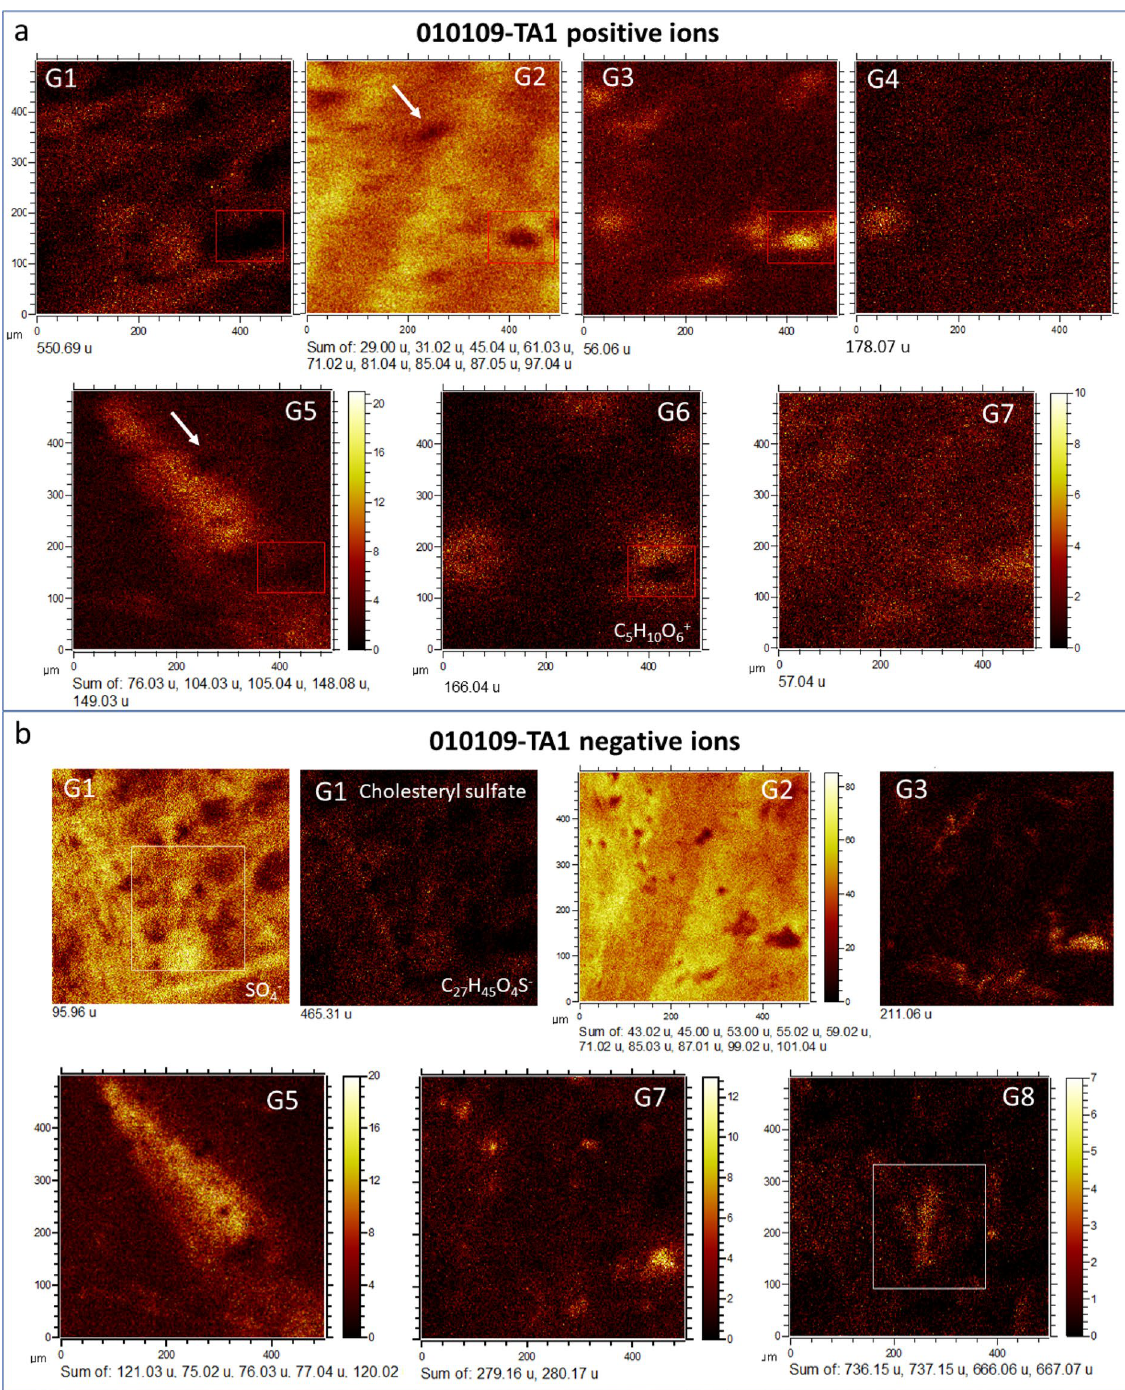
Figure 4. Occurrence of different biological microstructures in Target Area 1 (TA1) characterized by the imaging capabilities of ToF–SIMS as morphological Groups 1 to 8 through their molecular compositions. ( a ) Groups 1 to 8 outlined by the distribution of ( a ) positive and ( b ) negative fragments. The red rectangle traces a nodular microstructure in G3 occurring as an empty and complementary cast in G2, G5 and G6. The white rectangle encloses branched filamentous structures in G8 that complement part of the filamentous structures in G1 (see Fig. 5) suggesting that the fungal filamentous structure show compositional variations. The white arrow points at a void (see Supplementary Fig. 2) that is affecting some microstructures in G2 and G5. As discussed in the main text, the composition and structure of groups G1 to G8 suggest that the groups could come from the preservation of different biological structures such as filamentous fungi (G1 and G3), or plant fragments (G5 and